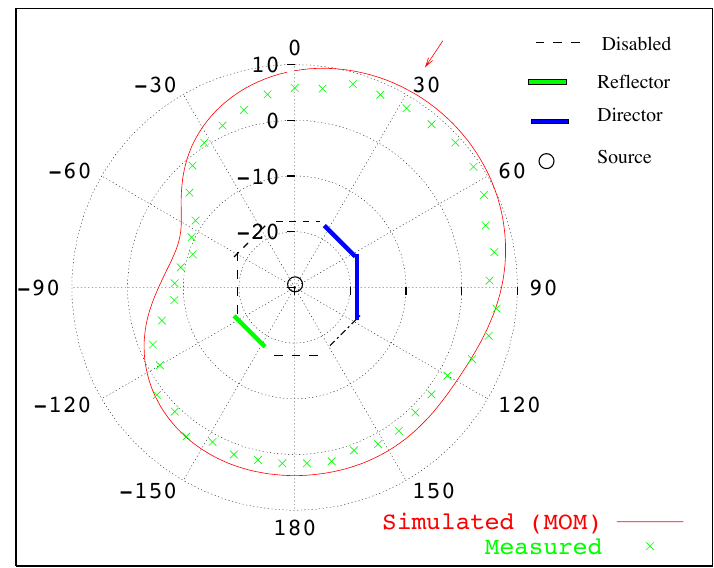
Figure 12. Experimental assessment. Single desired signal, impinging direction ( φ = 90). Beam-pattern ( θ = 90 ) plane.